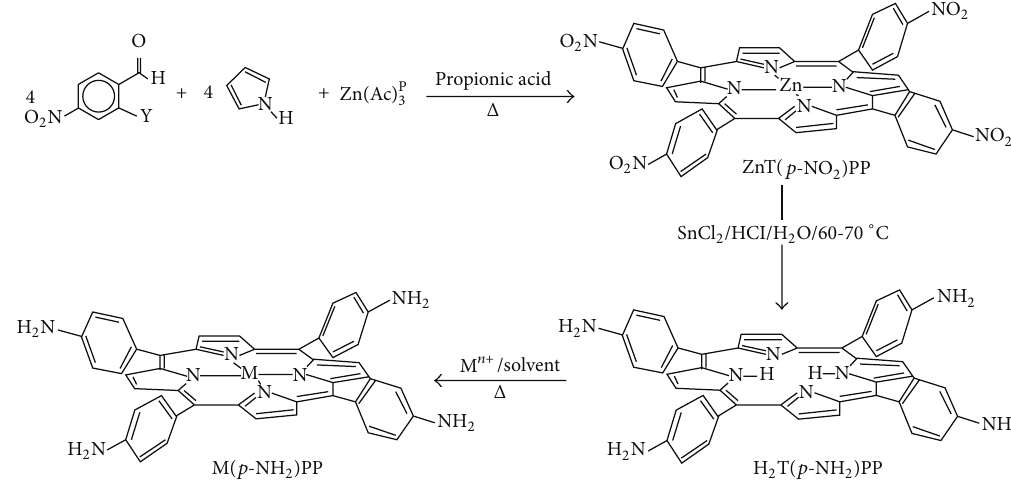
Figure 3: Synthesis route of H 2 T( p -NH 2 )PP species through the production of Zn( p -NO 2 )PP, zinc tetra-nitro-phenyl porphyrin, intermediary. Starting from the H 2 T( p -NH 2 )PP free base, it is possible to synthesize complexes with some other cations (M 𝑛+ ), including cobalt.